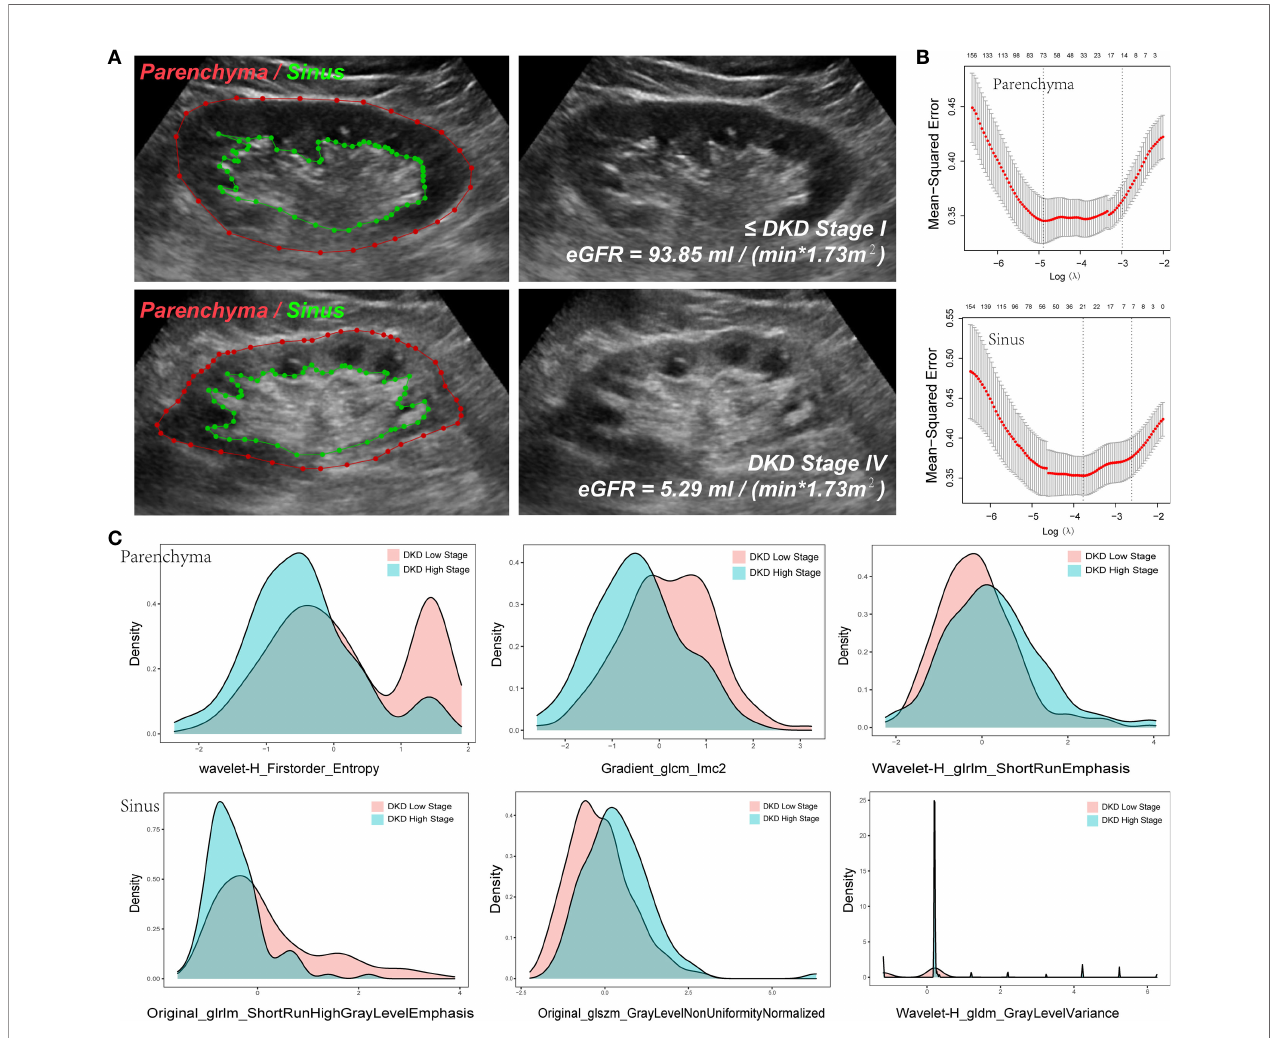
FIGURE 4 | Variables extracted from Parenchyma and Sinus. (A) The ROI of parenchyma and sinus in two DKD stage patients. (B) The Mean-square error plot of LASSO regression in parenchyma and sinus model. (C) The Density Plots between Extracted Radiomics Variables in parenchyma and